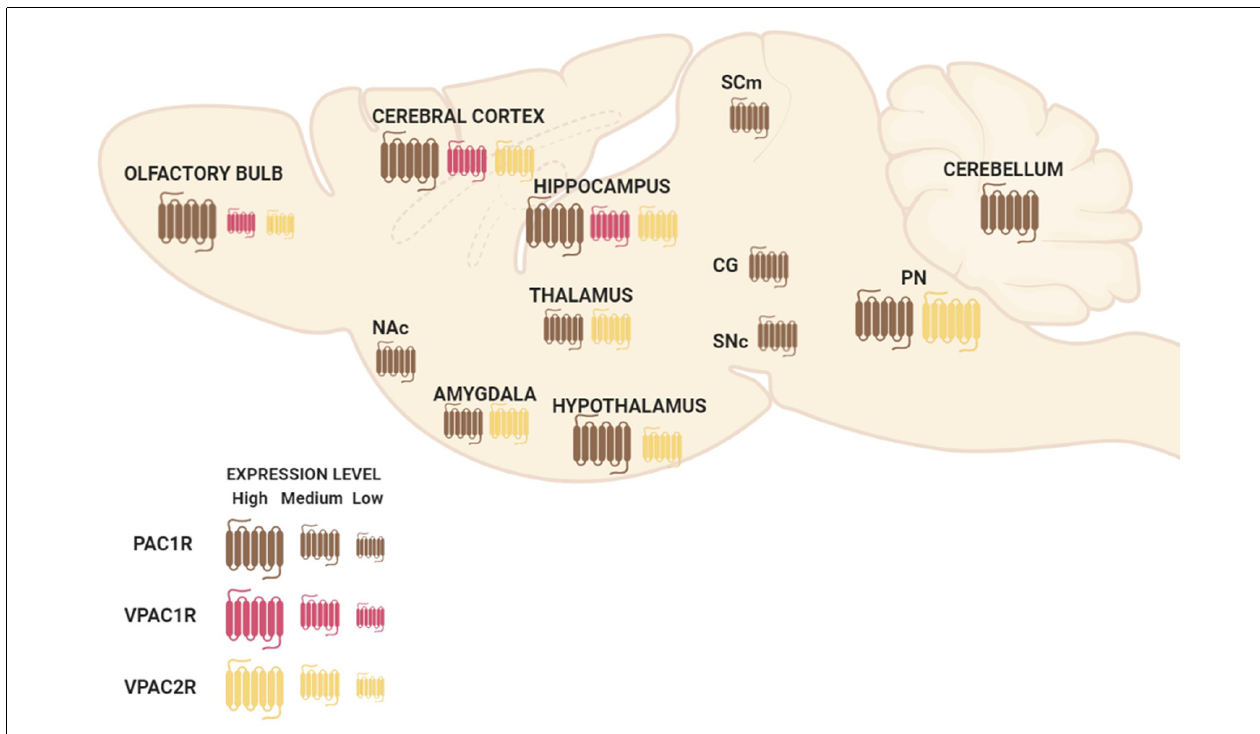
FIGURE 1 | Schematic representation of pituitary adenylate cyclase-activating polypeptide (PACAP) and vasoactive intestinal peptide (VIP) receptors’ mRNA distribution in a sagittal view of the mouse brain. Abbreviations: Nac, nucleus accumbens; SCm, superior colliculus; CG, central gray; SNc, substantia nigra pars compacta; PN, pontine raphe